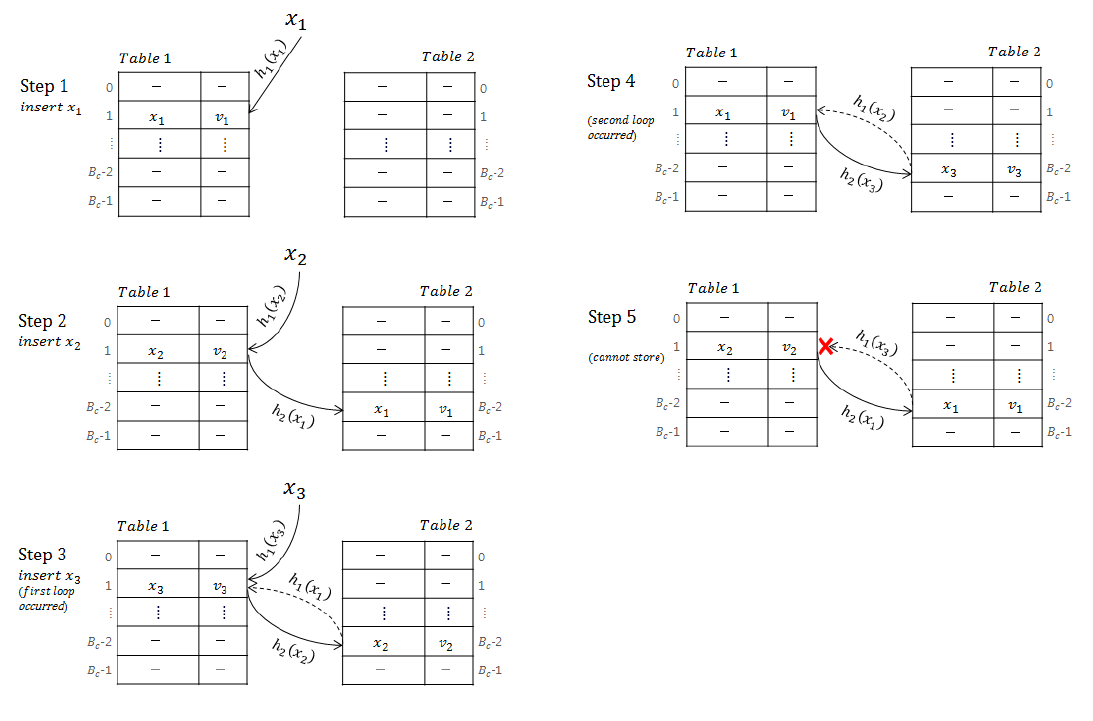
Figure 2. Element x 3 cannot be stored because of two loops in a cuckoo hash